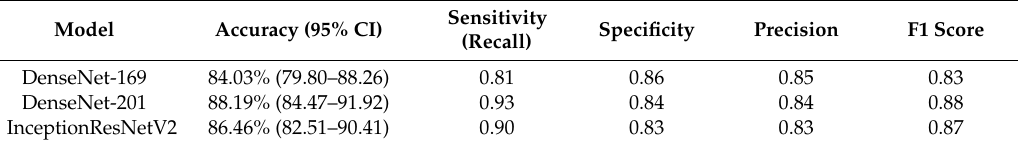
Table 2. Model Performance Summary—Humerus. Table 2a. Model Performance Summary—Humerus.